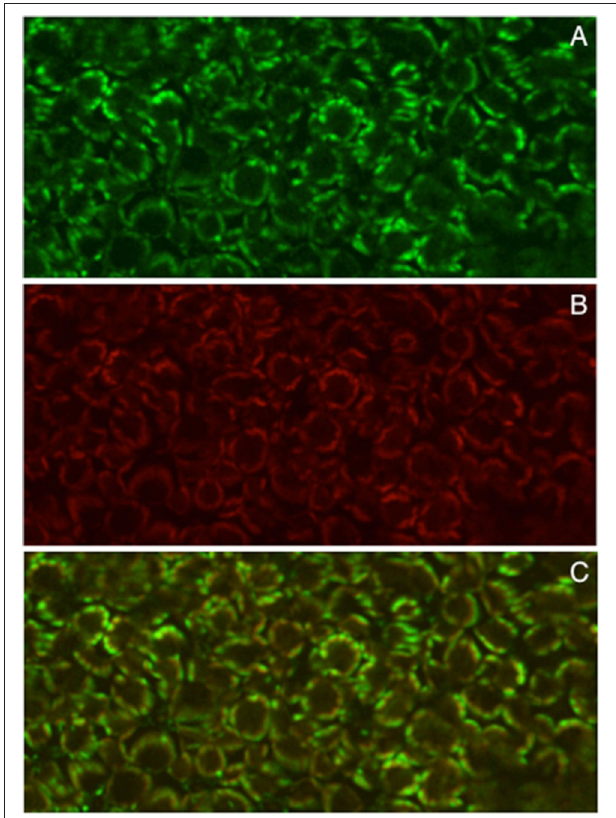
FIGURE 2 | Chloroplast localization of 35S-GLB1-GFP at the confocal laser scanning. (A) Green fluorescence. (B) Red fluorescence for chlorophyll localization. (C) Co-localization by merging images.